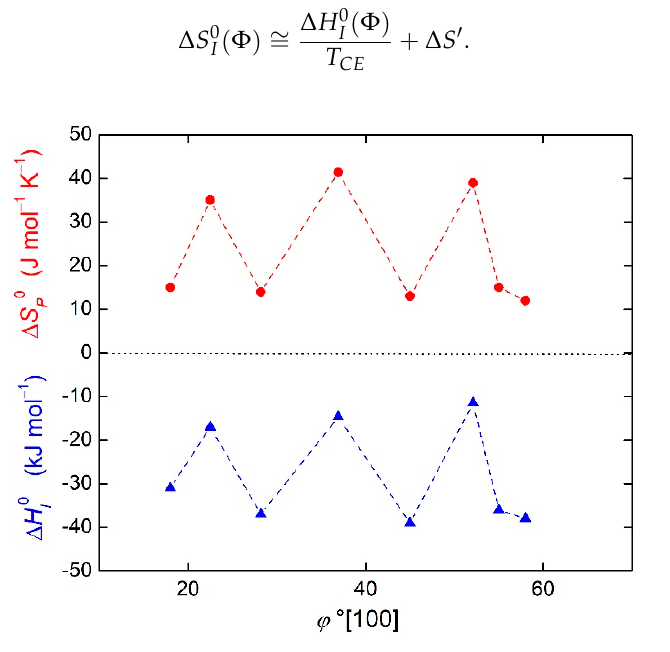
Figure 2. Orientation dependence of enthalpy (triangles) and entropy (circles) of phosphorus segregation at [100] symmetrical tilt grain boundaries of α -iron. Data are from Reference [14].